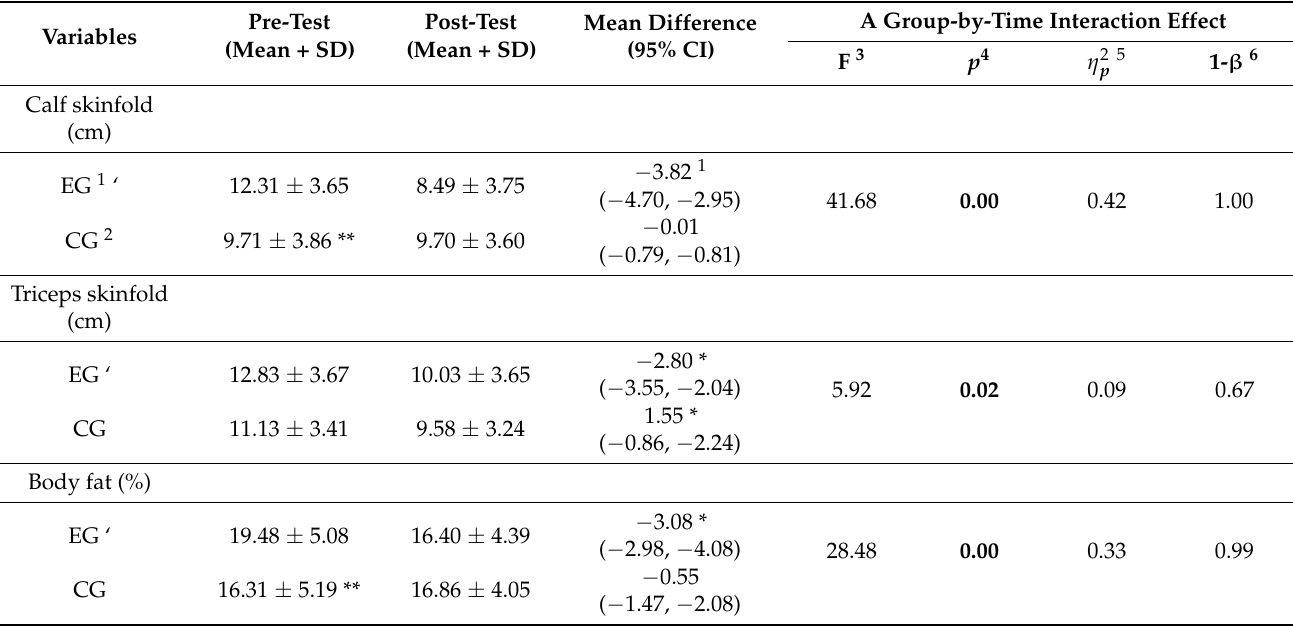
Table 4. Differences between EG ( n = 37) and CG ( n = 35) in body composition from pre- to post-test.